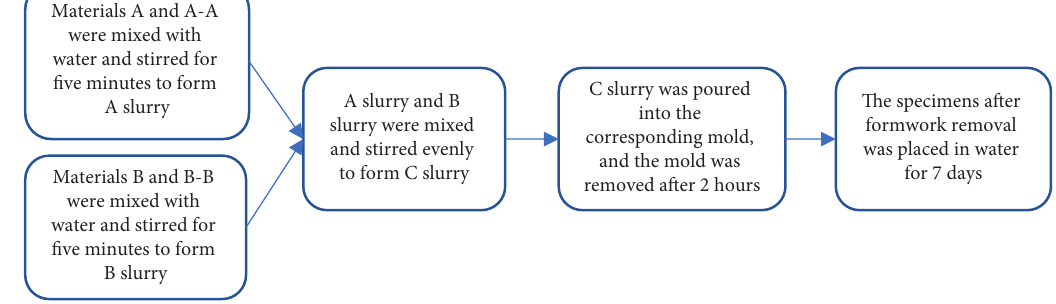
Figure 6: The specimen prepared flow chart.